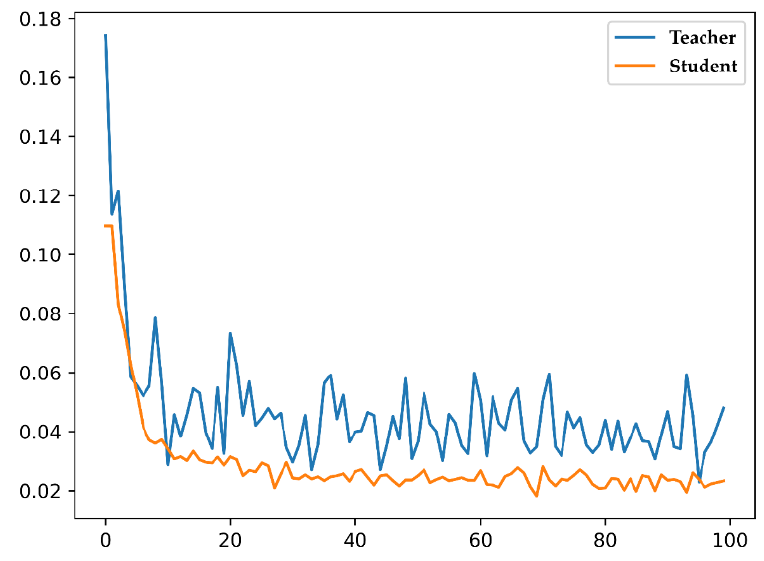
Figure 10. The training loss of STOAD model. The prediction parameter of Precision value reaches 96%, Recall value is 90%, and F1 value is